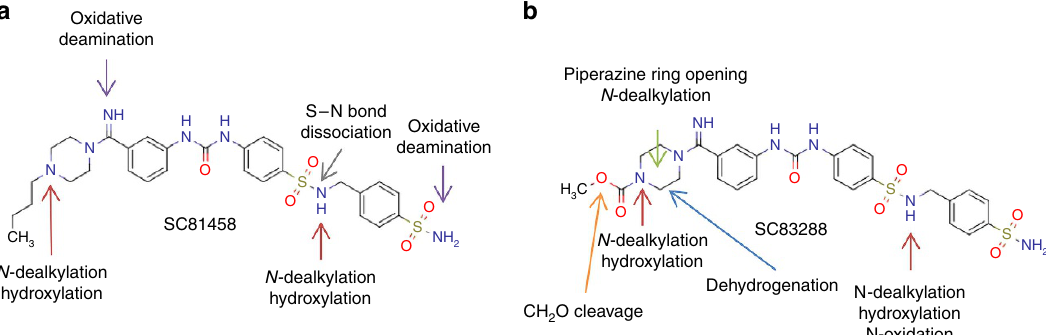
Figure 5 | Stability of SC81458 and SC83288 in liver microsomes. Suggested metabolic reactions and biotransformation sites of SC81458 ( a ) and SC83288 ( b ). Further detail is provided in Supplementary Figs 5 and